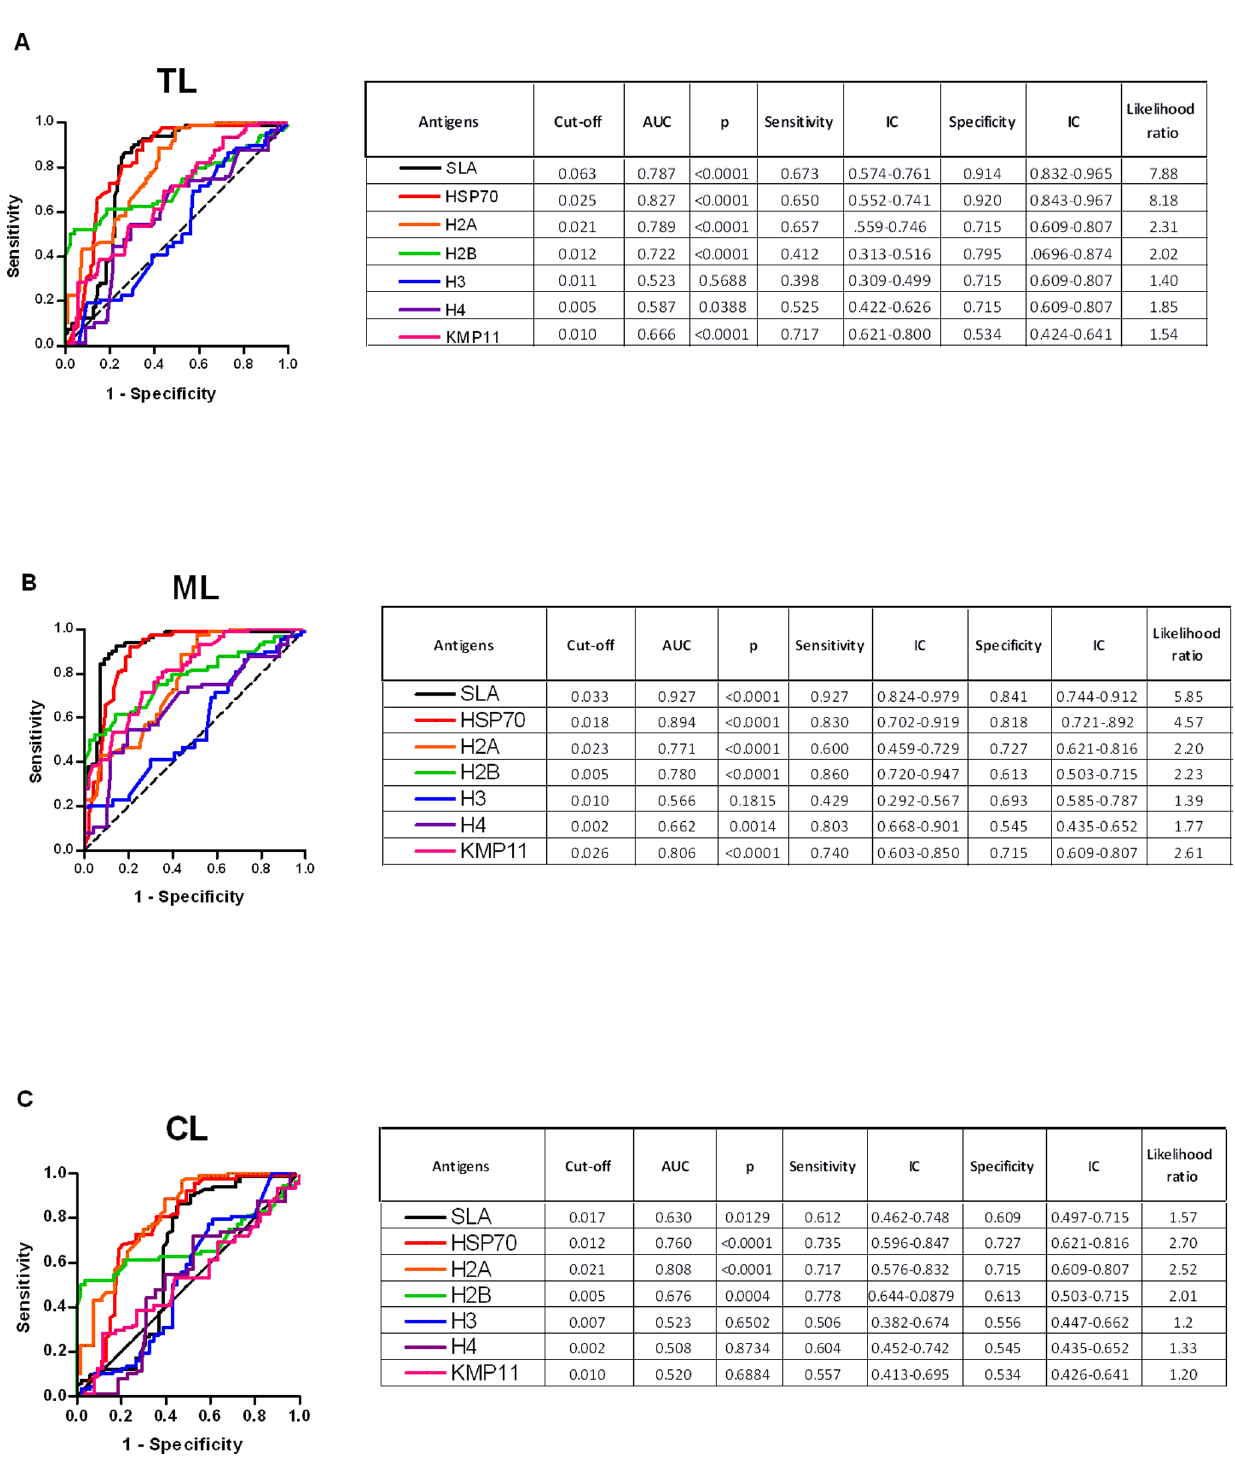
Figure 2. ROC curve of antibody levels predict the positivity thresholds against parasite antigens. The ROC curves were constructed using data obtained in ELISA performed with antigens and sera from TL (n=102) (A), ML (n=53) (B) or CL (n=49) (C) patients and control subjects from an endemic (n=39) and from a non-endemic (n=49) area. The solid lines represent the area under the curve and the dotted line represents the identity line curves. The tables show the detailed information obtained for each ROC curve (cut-off values chosen, area under the curve, the values of p, and the sensitivity and specificity with a confidence interval of 95% and the likelihood ratio).